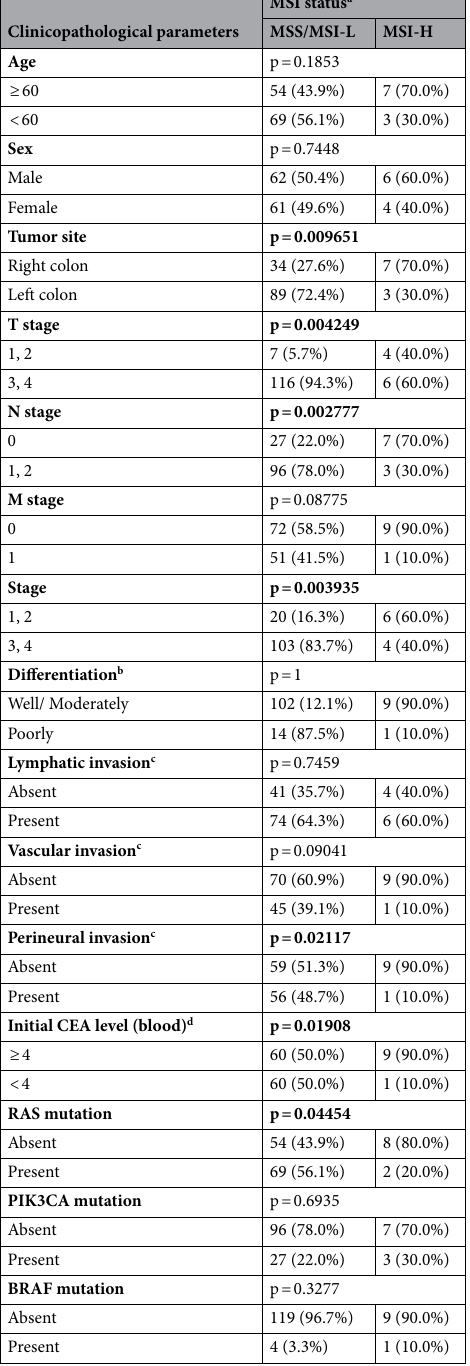
Table 3. Correlation of MSI status according to the clinicopathological data and RAS, PIK3CA, and BRAF mutations in our cohort. a A total of 12 patients have no MSI test result. b A total of 14 patients have no available data . c A total of 18 patients have no available data . d Three patients have no available